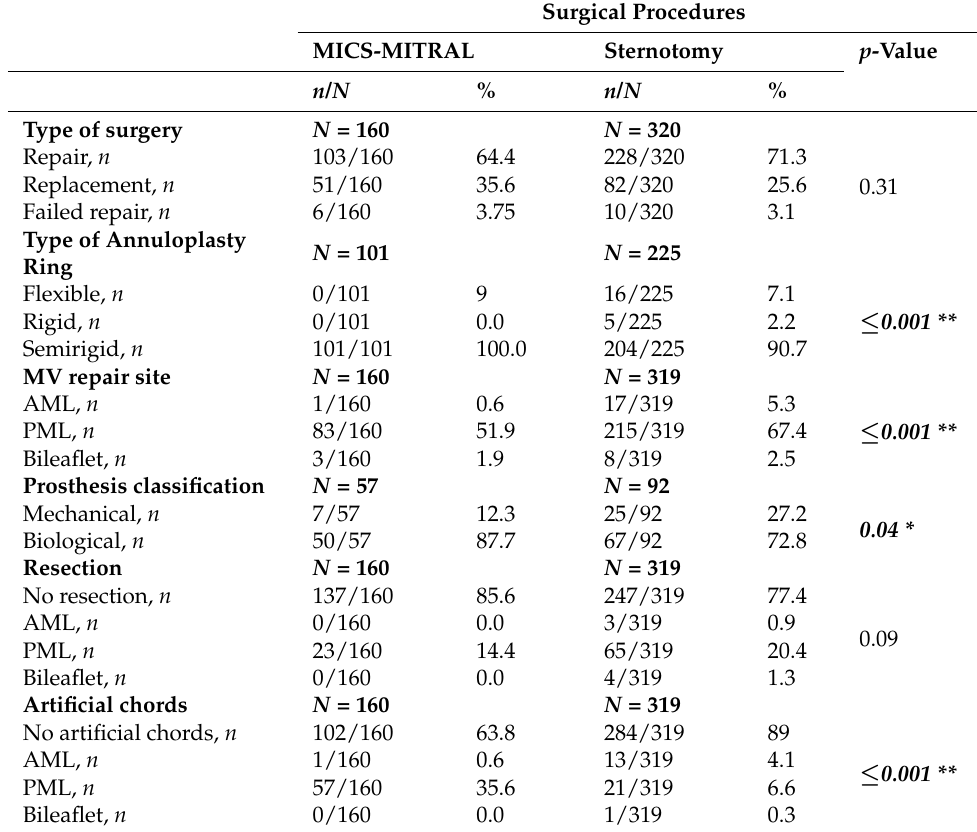
Table 4. Data of surgical procedures performed on the mitral